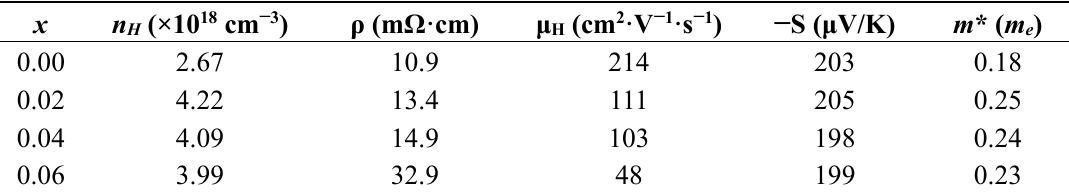
Table 10. The Hall carrier concentration n H , electrical resistivity ρ , Hall mobility μ H , negative Seebeck coefficient − | S |, and effective mass of carrier m* of the In 4 Pb 0.01 Sn 0.03 Se 2.9 Cl x ( x = 0, 0.02, 0.04, and 0.06) polycrystalline compounds at 320 K